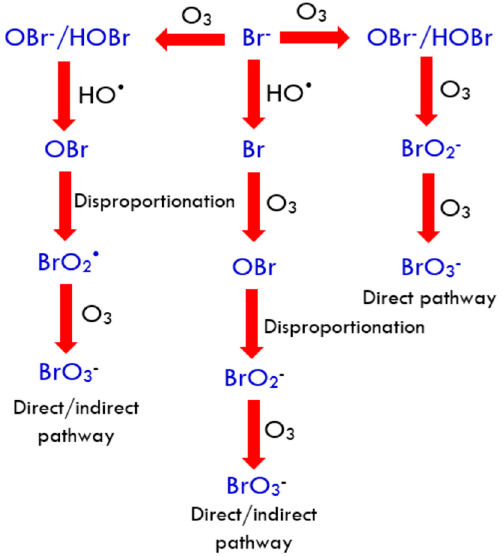
Figure 1. Bromate formation pathways [14],.